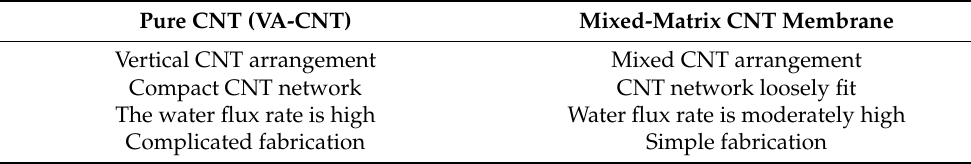
Table 1. Difference between VA-CNT and MM-CNT [38].